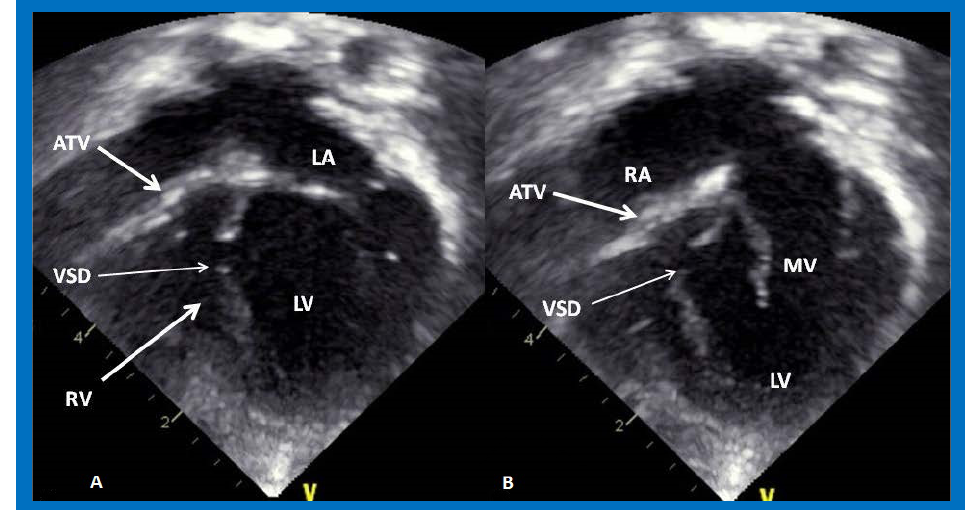
Figure 6. Selected video frames from apical four chamber, two dimensional echocardiographic views of a patient with tricuspid atresia showing an enlarged left ventricle (LV), a small right ventricle (RV) and a dense band of echoes at the site where the tricuspid valve echo should be (ATV) (thick arrow) with a closed ( A ) and open ( B ) mitral valve. A moderate sized ventricular septal defect (VSD) (thin arrow) is shown. LA, left atrium; RA, right atrium. Reproduced from Reference [29].